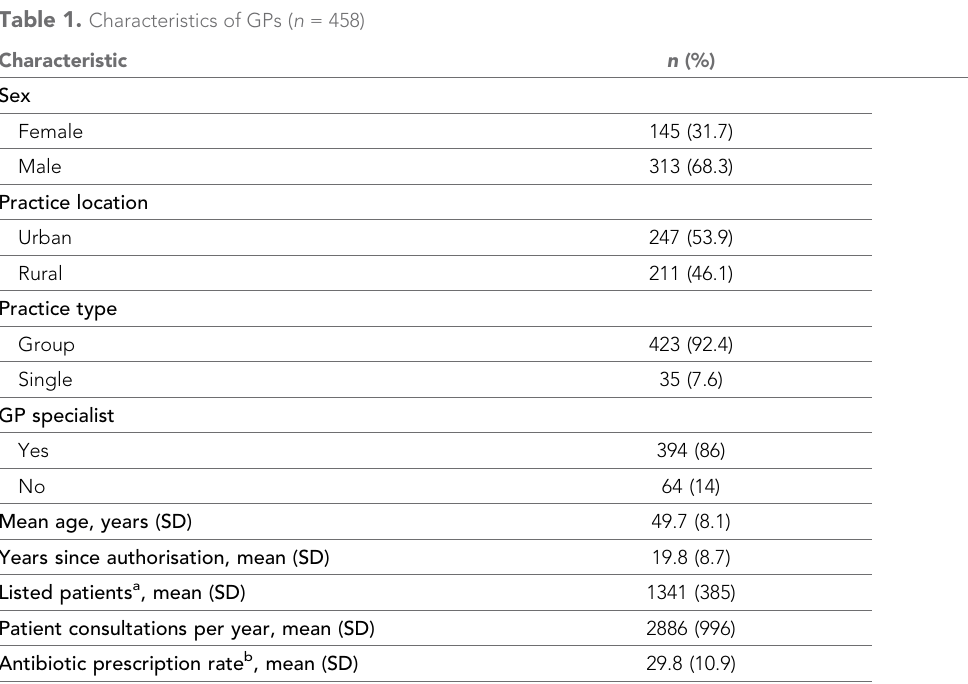
Table 1. Characteristics of GPs ( n =